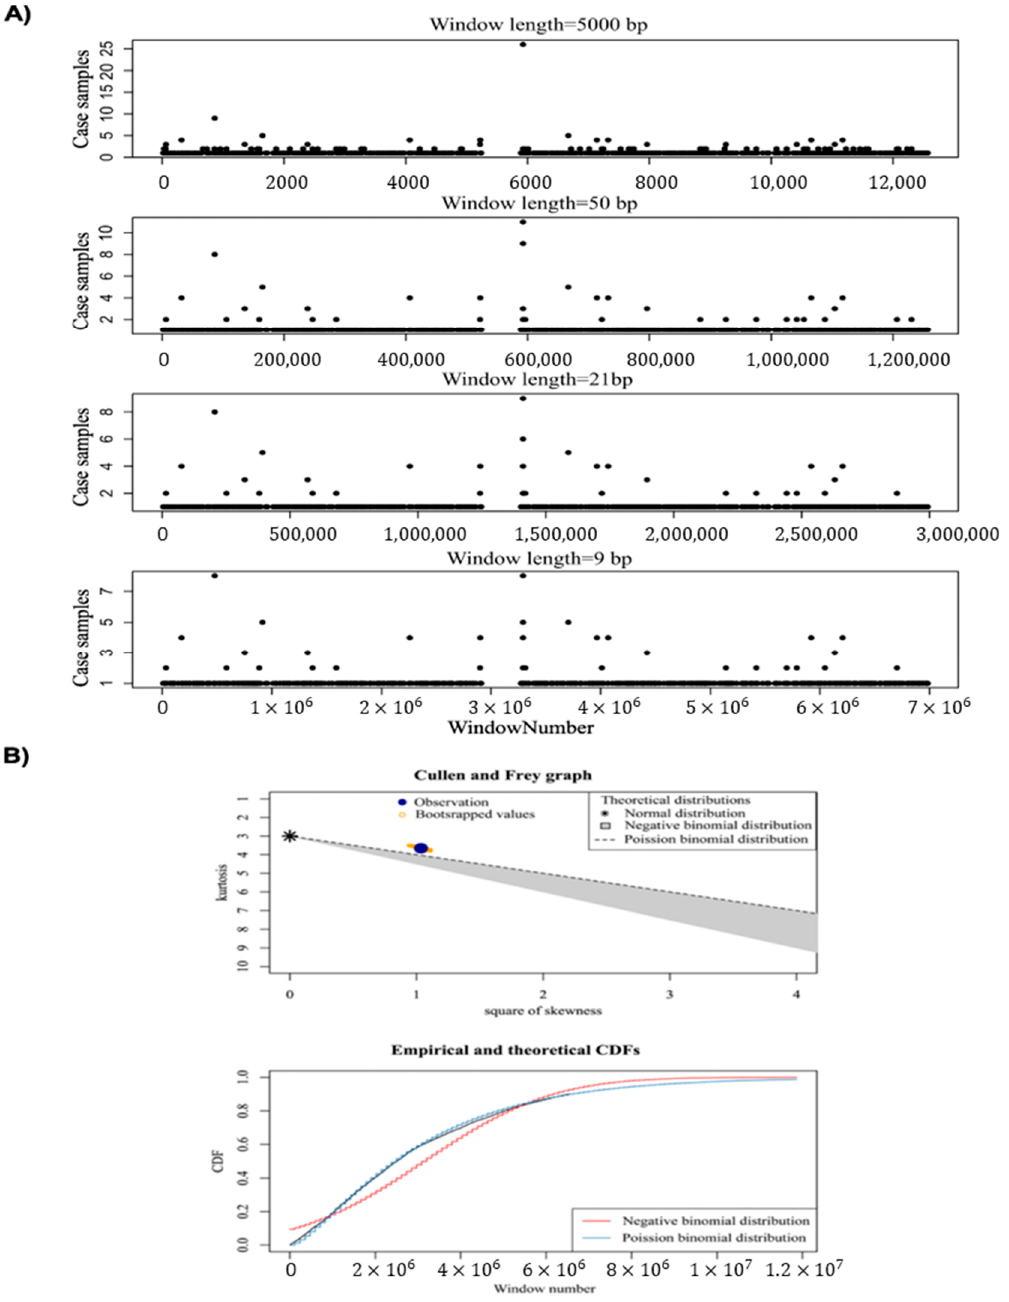
Figure 3. ( A ) Distribution of SPMs for different window sizes (500, 50, 21, and 9 bp) on chromosome 22. ( B ) The probability distribution for identified 21 bp bins by Cullen and Frey graph, and CDF plot. In total, 21,966 windows containing at least one sample with SPM were